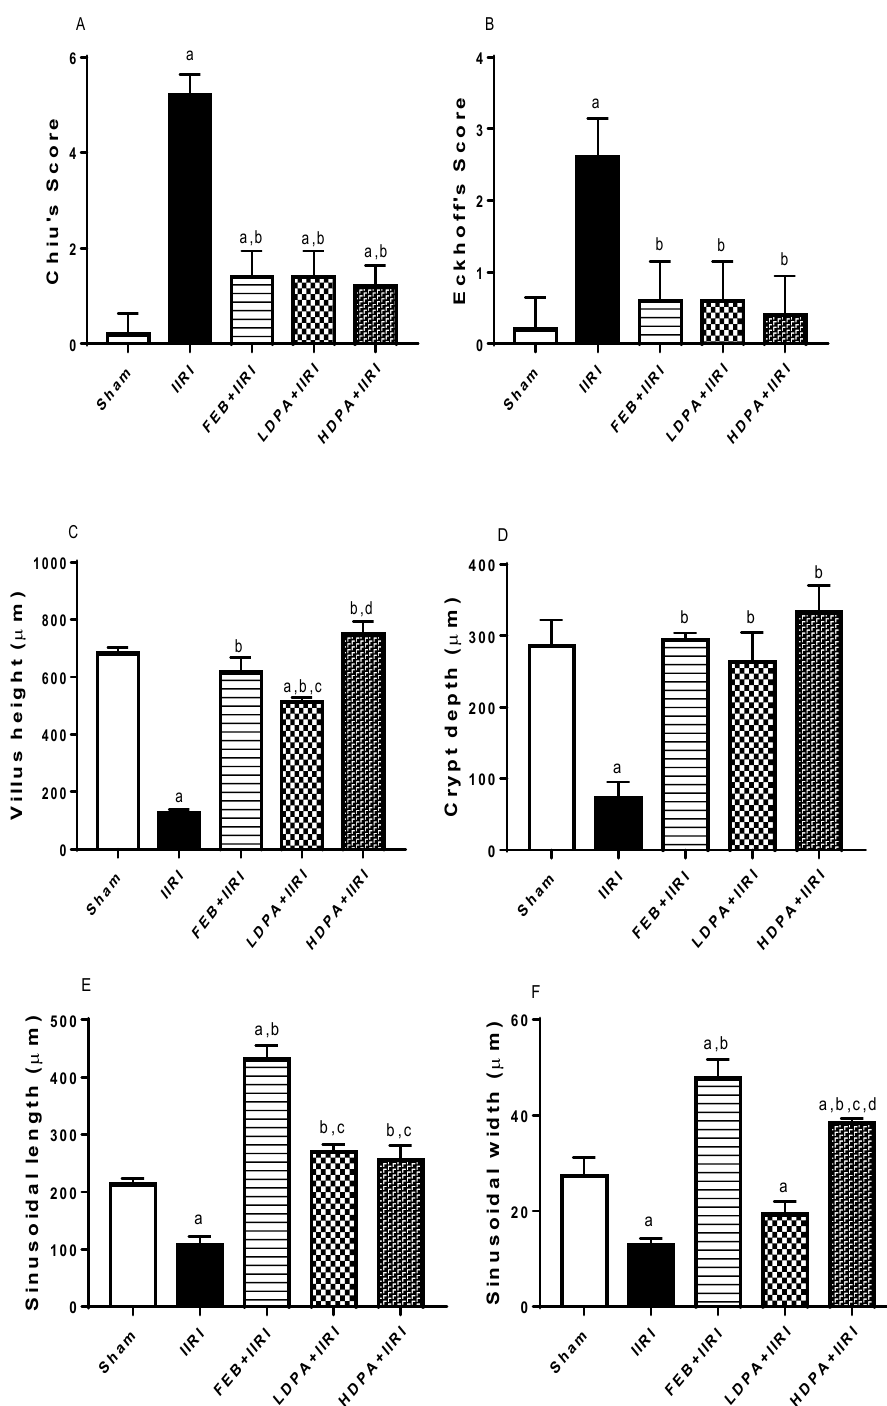
Figure 7. Effect of intestinal ischemia/reperfusion (I/R) and methanolic Phyllanthus amarus leaf extract on intestinal and hepatic histopathological changes using Chiu’s and Eckhoff’s score, respec- tively, intestinal villi height and crypt depth, and hepatic sinusoidal length and width. FEB, LDPA, and HDPA significantly reduced IIRI-induced rise in Chiu’s score ( A ) and Eckhoff’s score ( B ), as well as increase increased IIRI-induced reduction in villus height ( C ), crypt depth ( D ), sinusoidal length ( E ) and sinusoidal width ( F ). IIRI: intestinal ischemia/reperfusion injury, FEB: febuxostat, LDPA: low-dose Phyllanthus Amarus, HDPA: high-dose Phyllanthus Amarus, a p < 0.05 versus sham, b p < 0.05 versus IIRI, c p < 0.05 versus FEB+IIRI, d p < 0.05 versus LDPA+IIRI. Values represent the mean for five replicates ± the standard deviation.